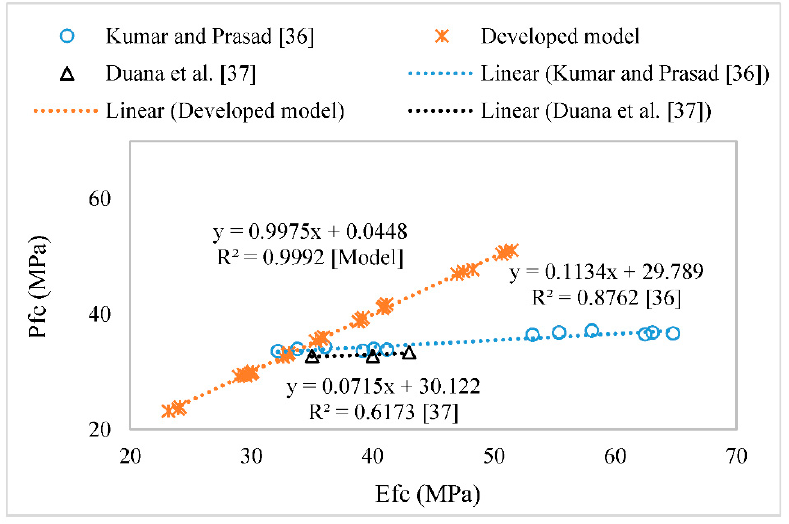
Figure 14. Comparison of the developed model with previous studies.